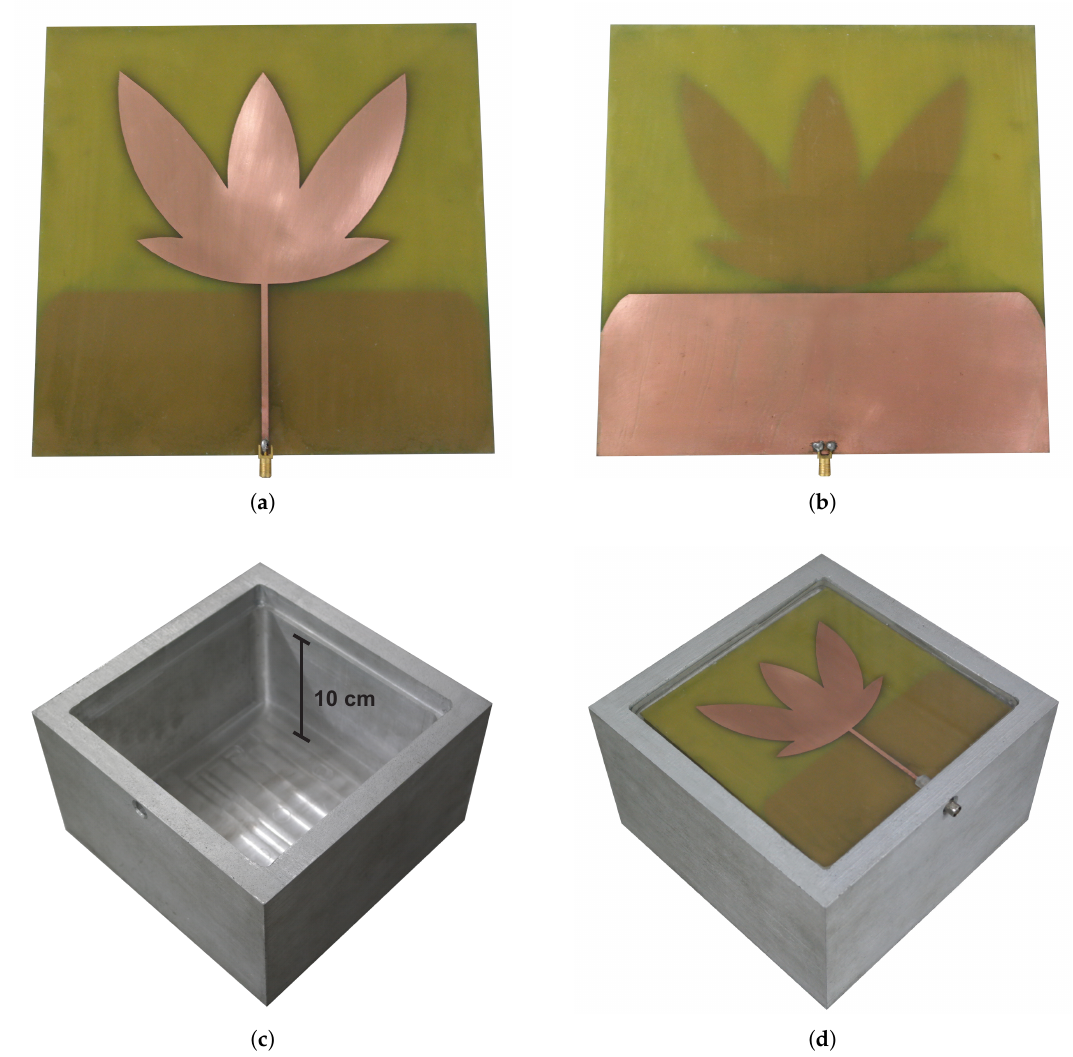
Figure 9. Components and assembly of the UHF sensor. ( a ) Radiating element of the bio-inspired antenna. ( b ) Ground plane on the other side of the antenna. ( c ) Aluminum sensor enclosure. ( d ) Complete assembly of the UHF